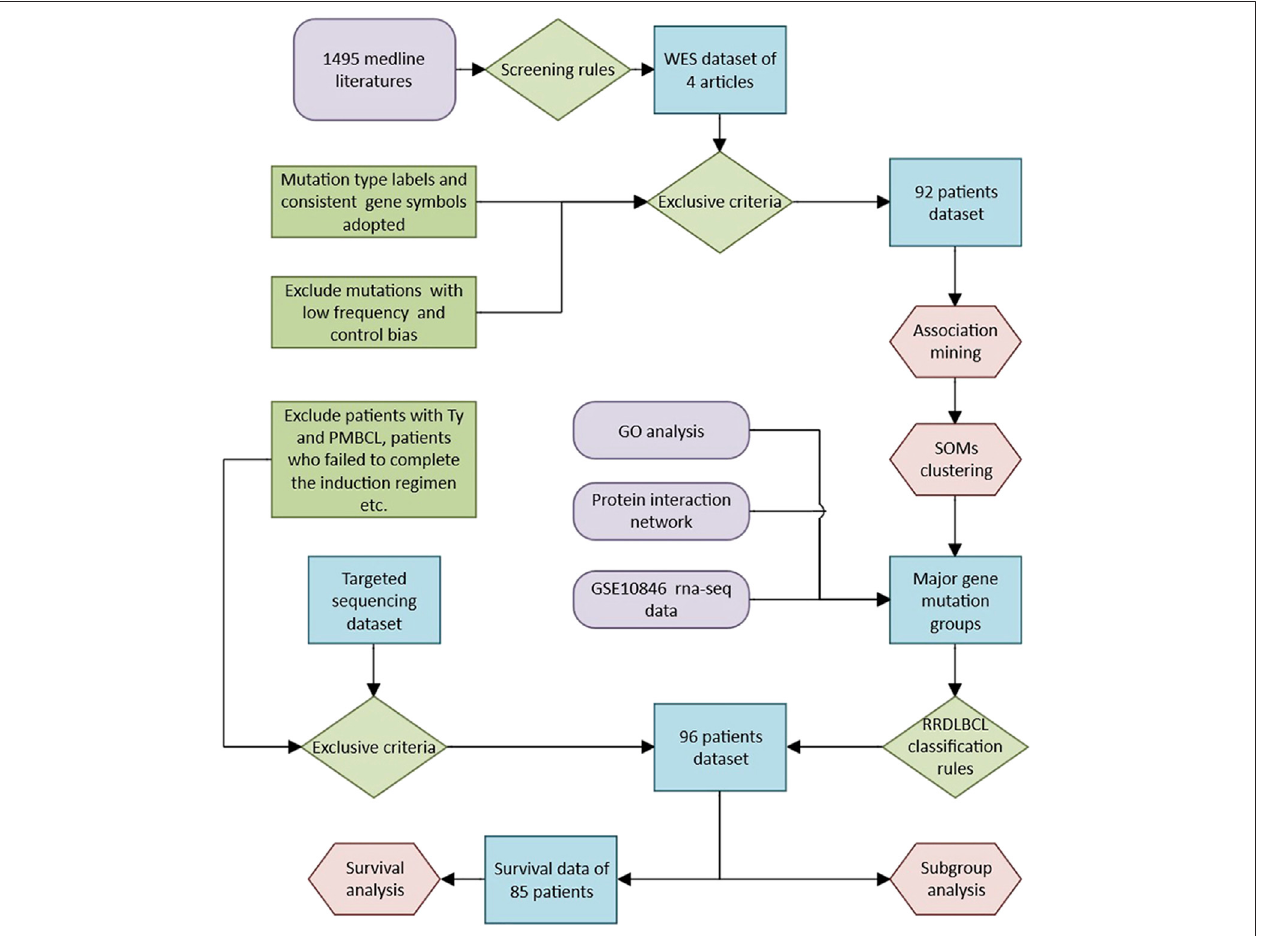
FIGURE 1 | Roadmap of the research method of this